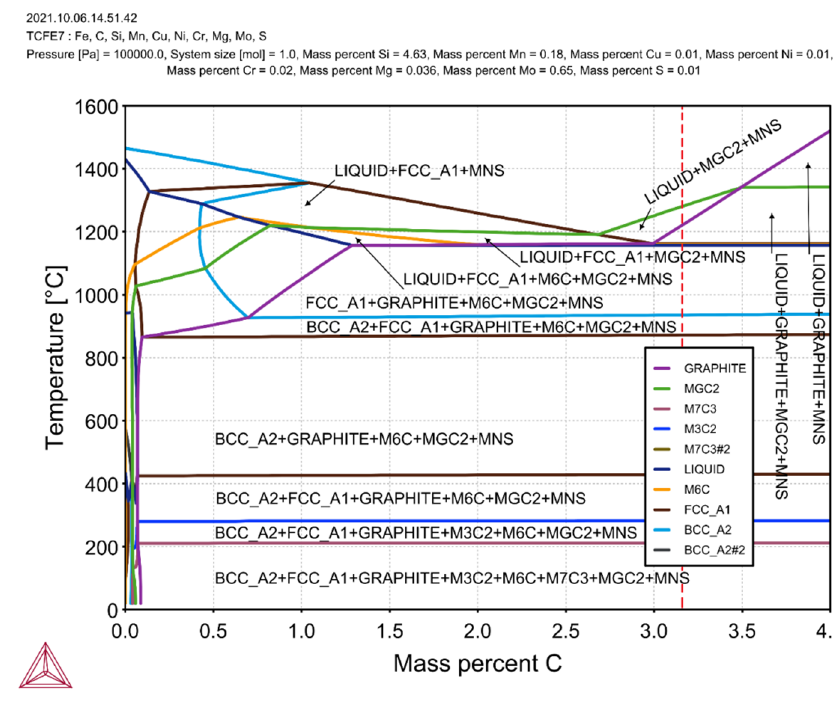
Table 1. Chemical compositions of EN-GJS-SiMo45-6 alloy (wt.